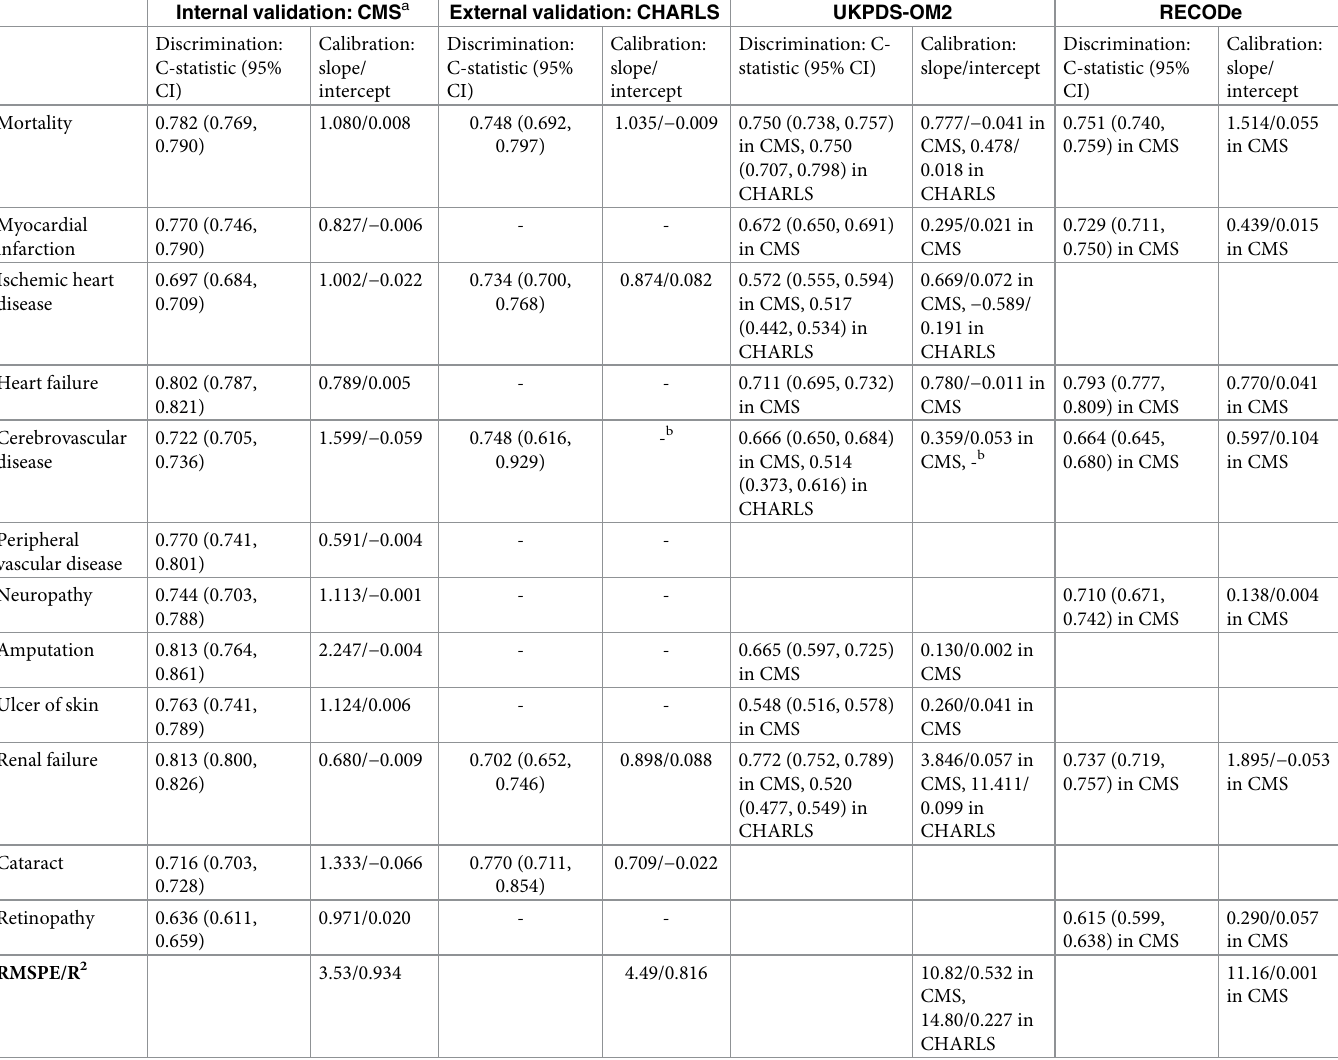
Table 2. Internal and external validation statistics for CHIME, UKPDS-OM2, and RECODe for